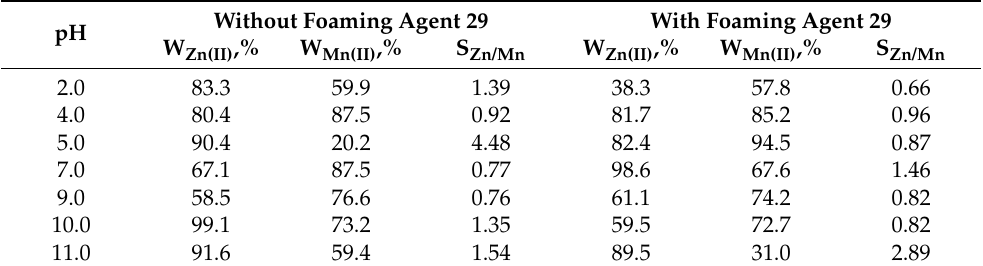
Table 5. Results of Zn(II) and Mn(II) flotation using collector 33 in a 10 min process with and without foaming agent 29 at pH from 2.0 to 11.0; (Zn) = 0.00168 M, (Mn) 0.00091 M, (33) = 5.0 × 10 − 3 M, (29) = 2.0 × 10 − 4